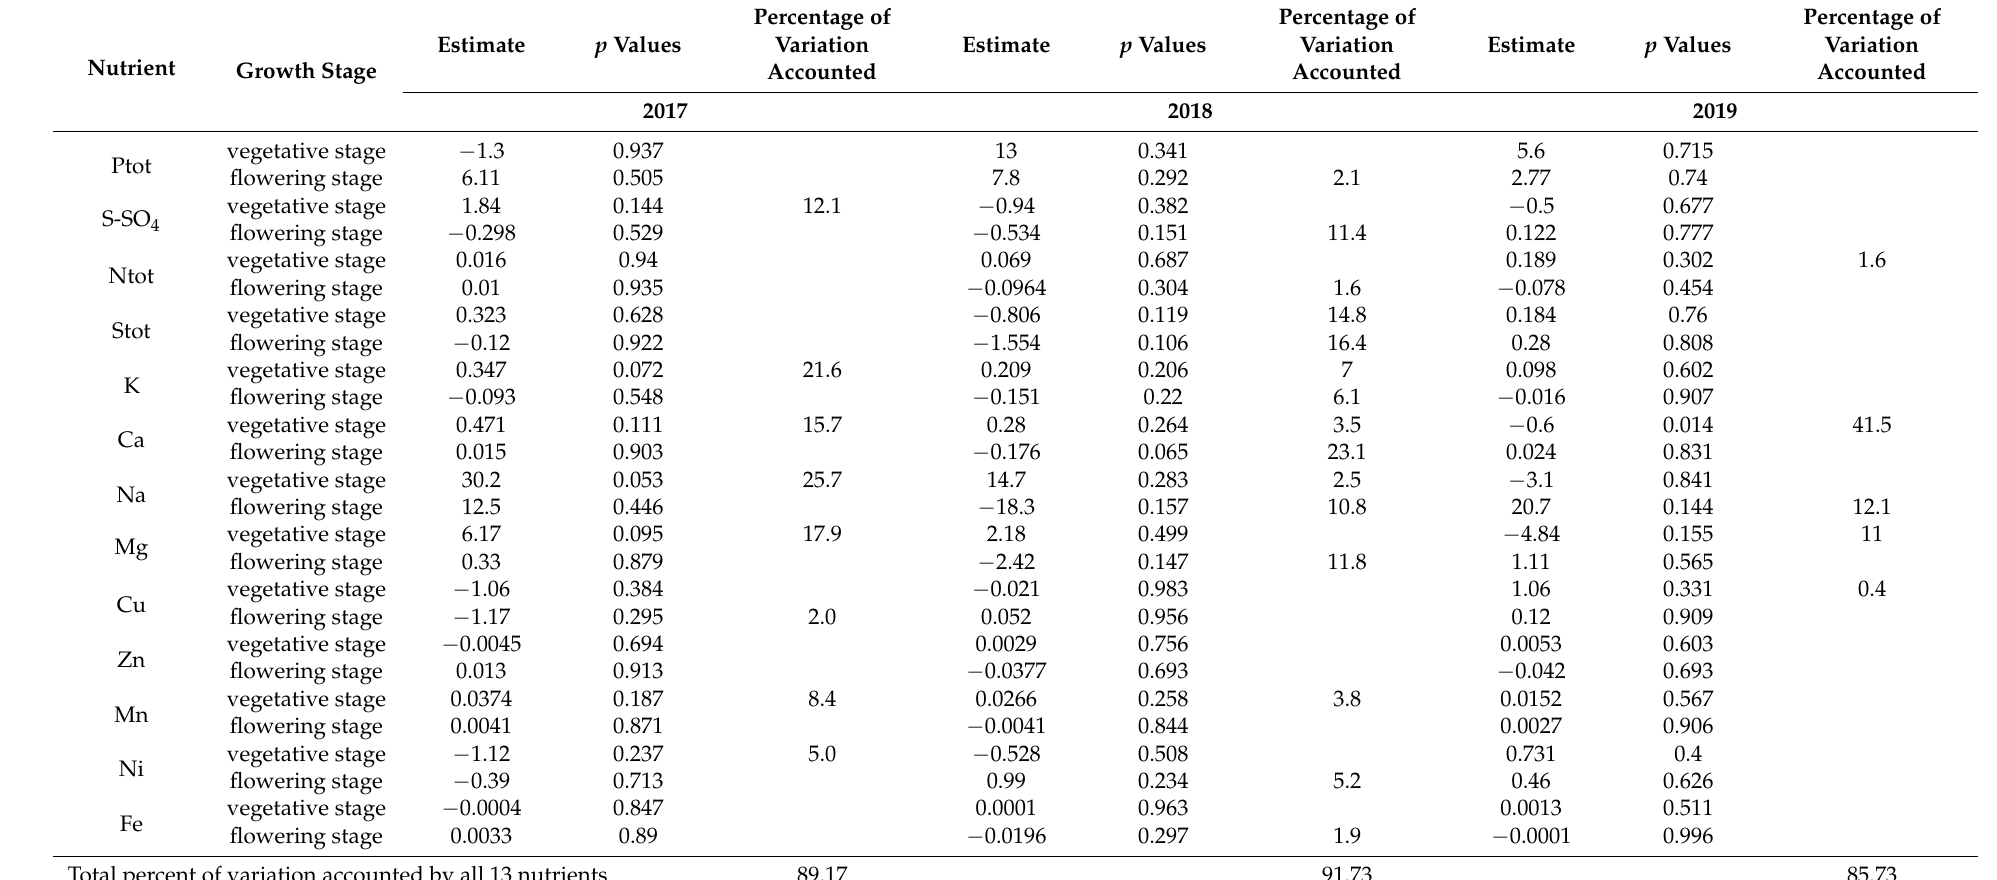
Table 8. The associations between analyzed nutrients and resistance to Delia radicum (N =